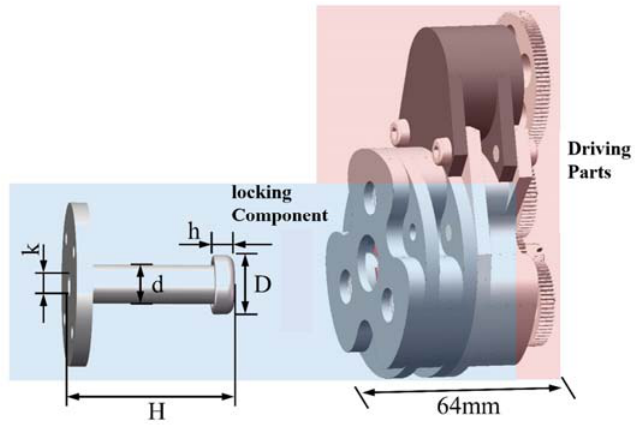
Figure 2. Overall structure of the locking assembly.